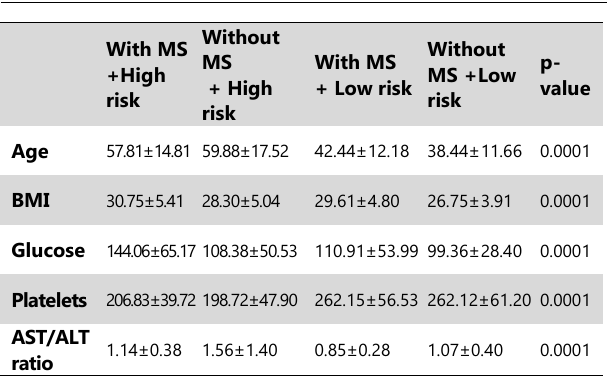
Table . Significant Main Risk Factors for Developing Liver Fibrosis in Subjects with and without Metabolic